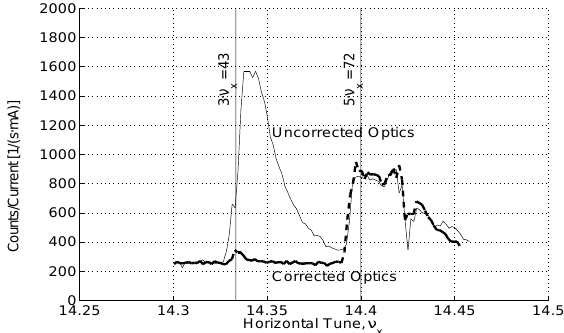
FIG. 11. Horizontal tune scans before (top) and after (bottom) the optic is corrected. The vertical tune is kept constant at 8.15. At each horizontal and vertical tune, the count rate (as measured in a gamma counter) divided by beam current is